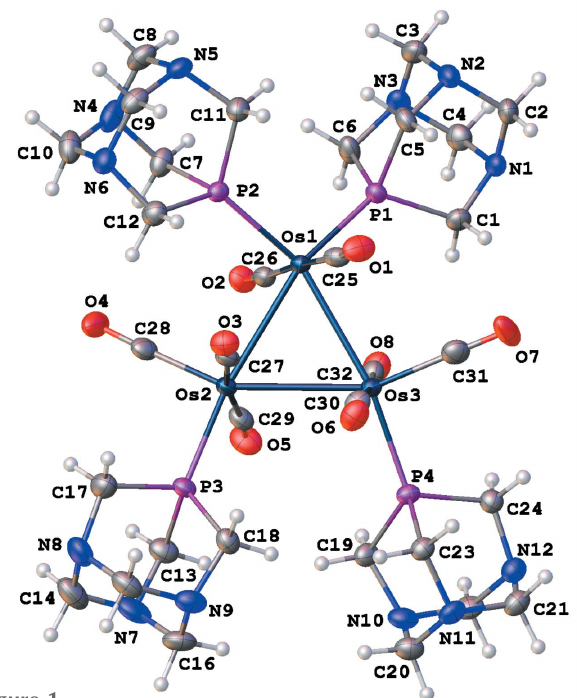
Figure 1 View of the title molecule showing the atom-labeling scheme. Displace- ment ellipsoids are scaled to the 50% probability level. The Os 3 core is represented by the major disorder component. For the sake of clarity, the atoms labels for C15 (in front of N7) and C22 (behind N11) are omitted.